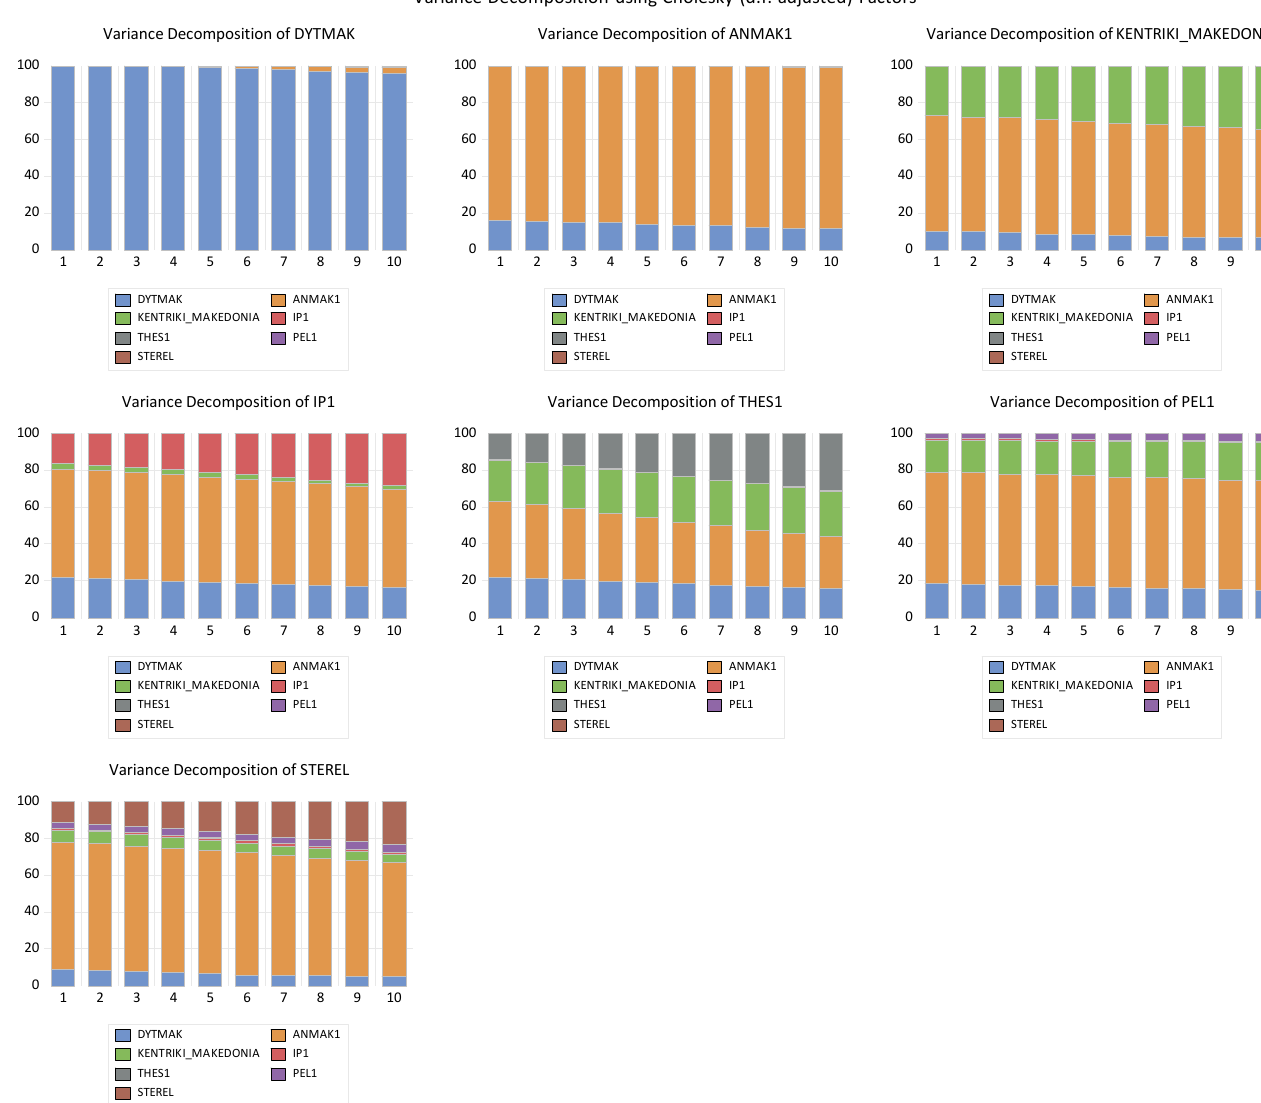
Figure 5. Variance decomposition analysis. (Source NSI own elaboration).